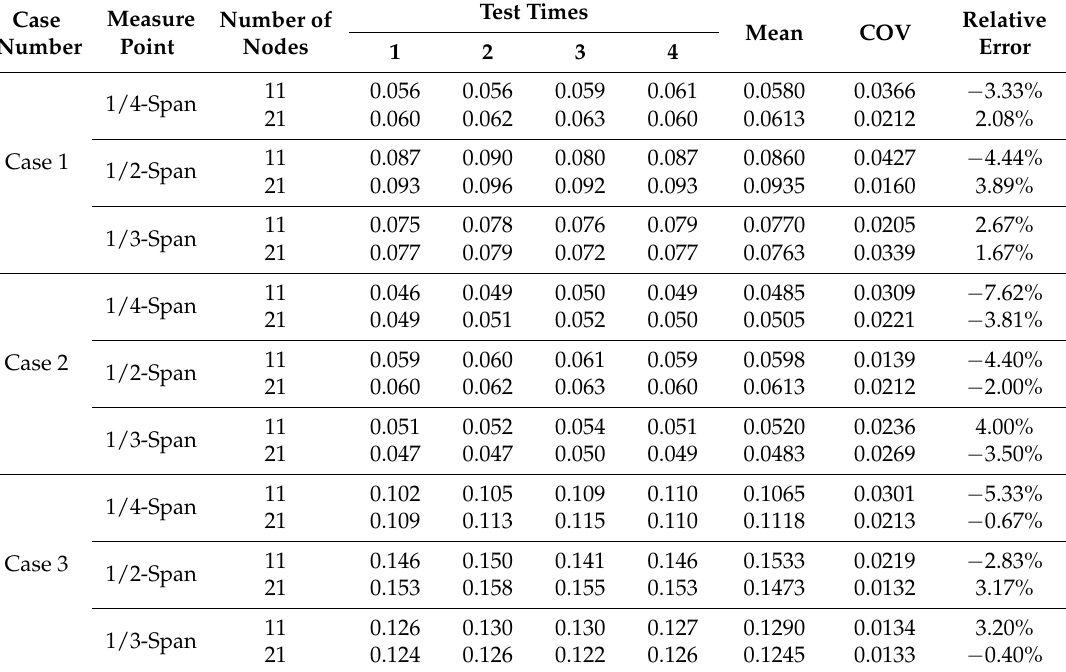
Table 4. Deflection results measured by dynamic test method (unit: